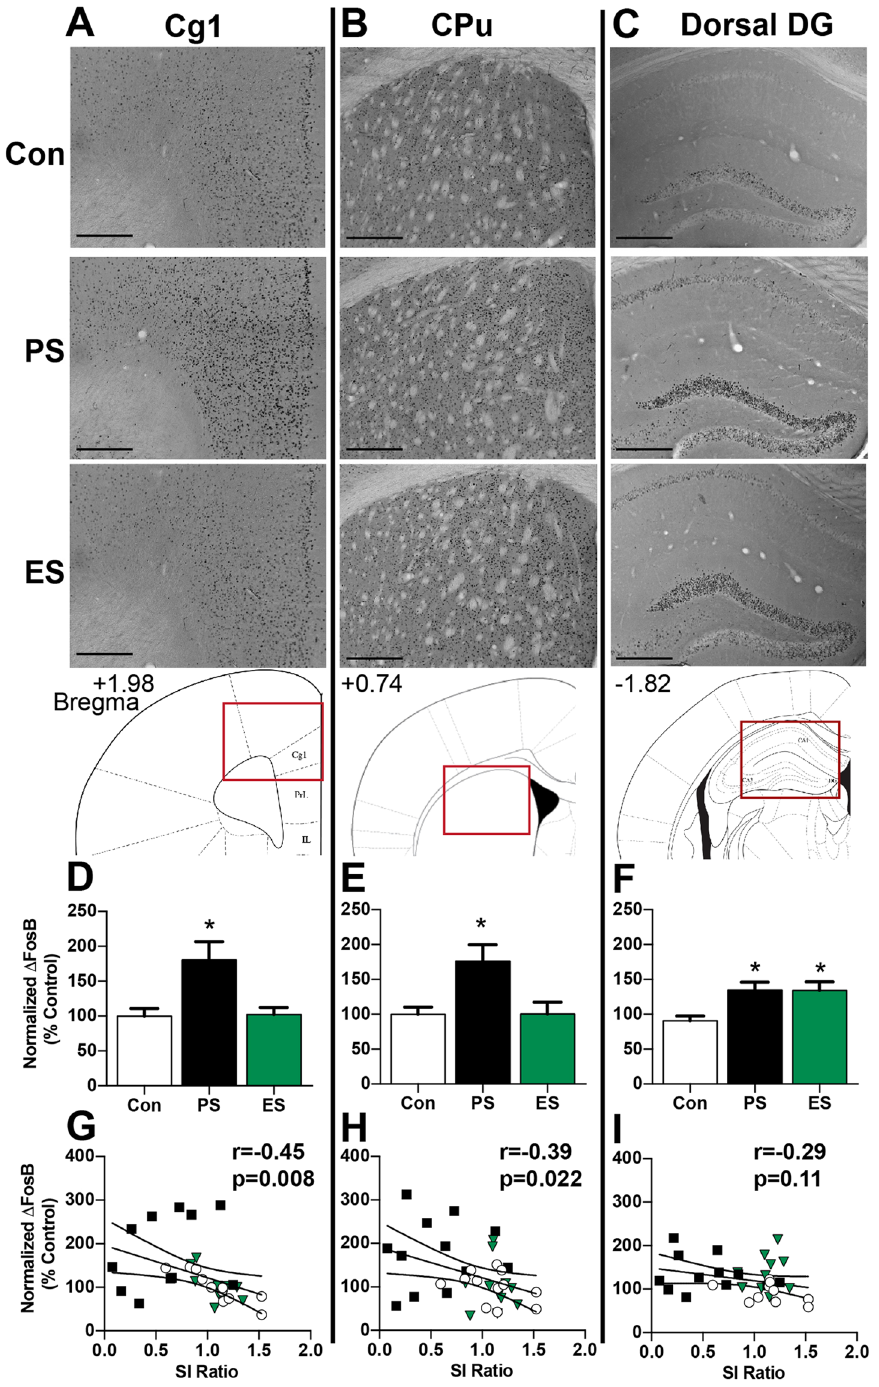
Figure 2. CSDS increases the number Δ FosB-positive cells in select brain regions. Top panel: Representative images of Δ FosB-positive nuclei visualized by DAB-staining in control (Con), physical stress (PS), and emotional stress (ES) mice in ( A ) cingulate cortex (Cg1), ( B ) caudate putamen (CPu), ( C ) Dorsal dentate gyrus (DG) (Scale bar: 200 μ m). Schematics of the location of each brain region (red box) within a coronal slice are depicted below (adapted from 36 ). ( D – F ) Quantification of the number of Δ FosB-positive nuclei, displayed as percent of control. ( G – I ) Correlation of Δ FosB counts and SI ratio. Pearson r values and p values are noted on each graph. n = 9–12 mice/group; * p < 0.05 compared to control, Tukey’s post-hoc